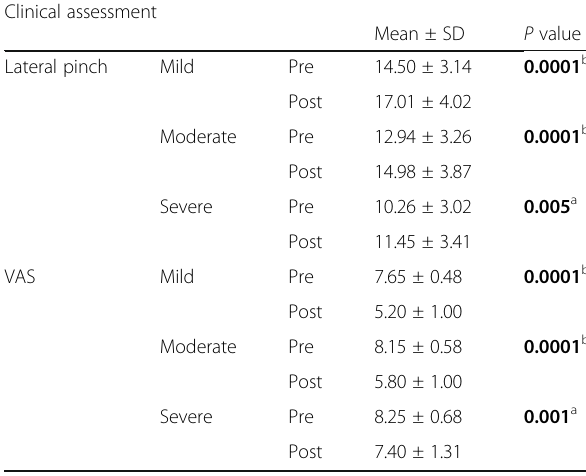
Table 2 Comparison between pre- and post-clinical data within mild, moderate, and severe groups Clinical assessment